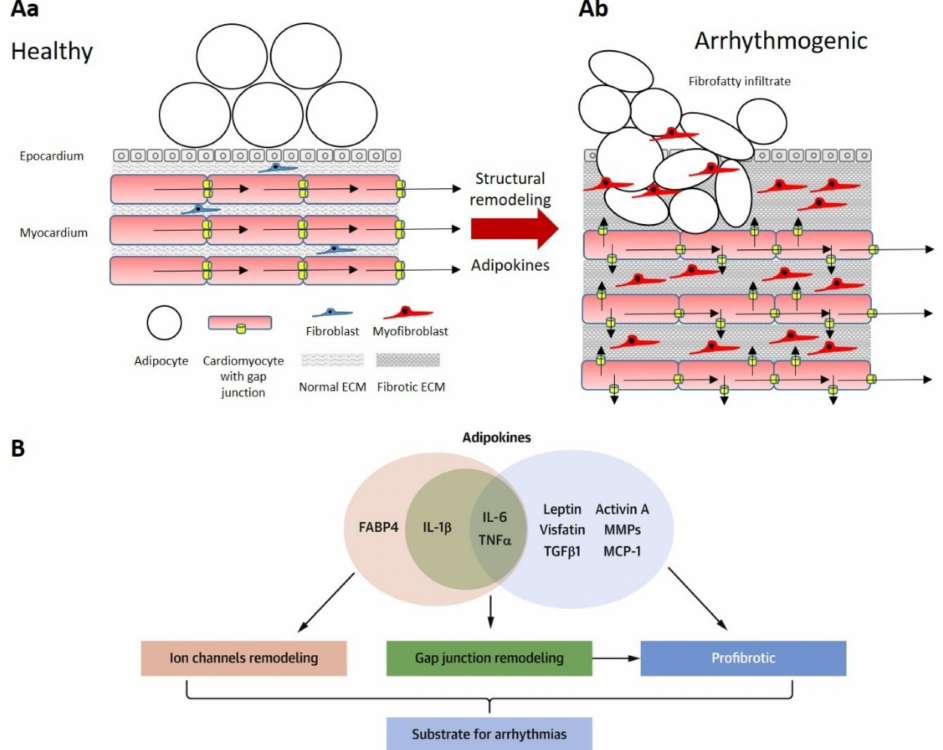
Figure 3. Formation of arrhythmogenic substrate as a result of fibrofatty infiltrates increasing conduction heterogeneity across the atrial myocardium. Panel ( Aa ): Action potential (AP) conduction is linear in healthy myocardium, where the endomysium is comprised of a thin layer of connective tissue with fibroblasts and EAT is predominantly supramyocardial. In contrast, with fibrofatty infiltration of the myocardium, fibrosis, structural remodeling, and production of pro-inflammatory and pro-fibrotic adipokines (Panel ( Ab )), AP conduction becomes ‘zigzag’ and the myocardium is at risk of arrhythmias. Examples of specific adipokines associated with arrhythmogenic remodeling are shown in Panel ( B ); FABP4 = FA binding protein 4, IL = interleukin, TNF = tumor necrosis factor, TGF = transforming growth factor, MMP = matrix metalloproteinases, MCP = monocyte chemoattractant protein. Panel ( B ) reproduced from Ernault et al. [34] under the Creative Commons CC-BY-NC-ND